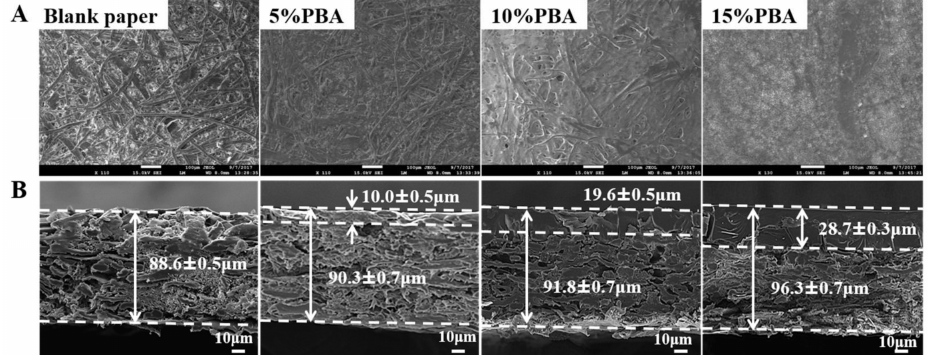
Figure 1. ( A ) SEM images of the blank control paper and papers coated with 5, 10 and 15% of PBA. ( B ) SEM images of the cross-sections: the blank control paper and papers coated with 5, 10 and 15% of PBA.